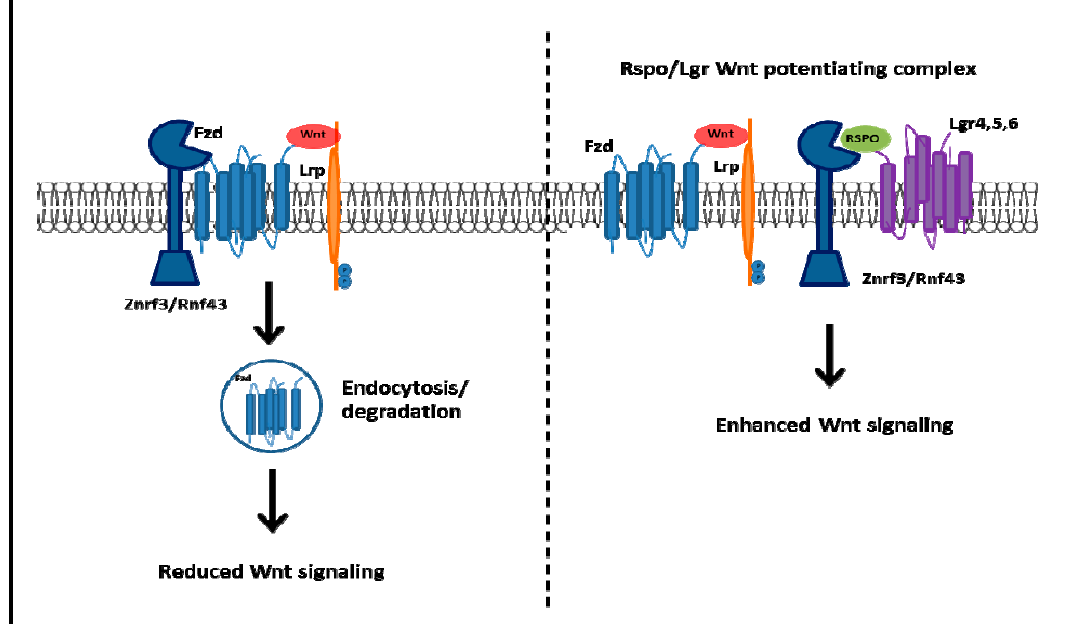
Figure 2. The intensity of Wnt signaling is enhanced by the formation of the Rspo/Lgr-Wnt potentiating complex at the cell membrane. The Wnt-activated ubiquitin ligases, Rnf43 and Znrf3, function in a negative feedback circuitry to control the intensity of Wnt signaling activation. Rnf43/Znrf3 binds to Fzd receptors leading to polyubiquitination, endocytosis and destruction by lysomes [87]. In the presence of Rspo Rnf43/Znrf3 is neutralized facilitating the accumulation of Fzd receptors at the plasma membrane and enhances the intensity of Wnt signal strength [85].